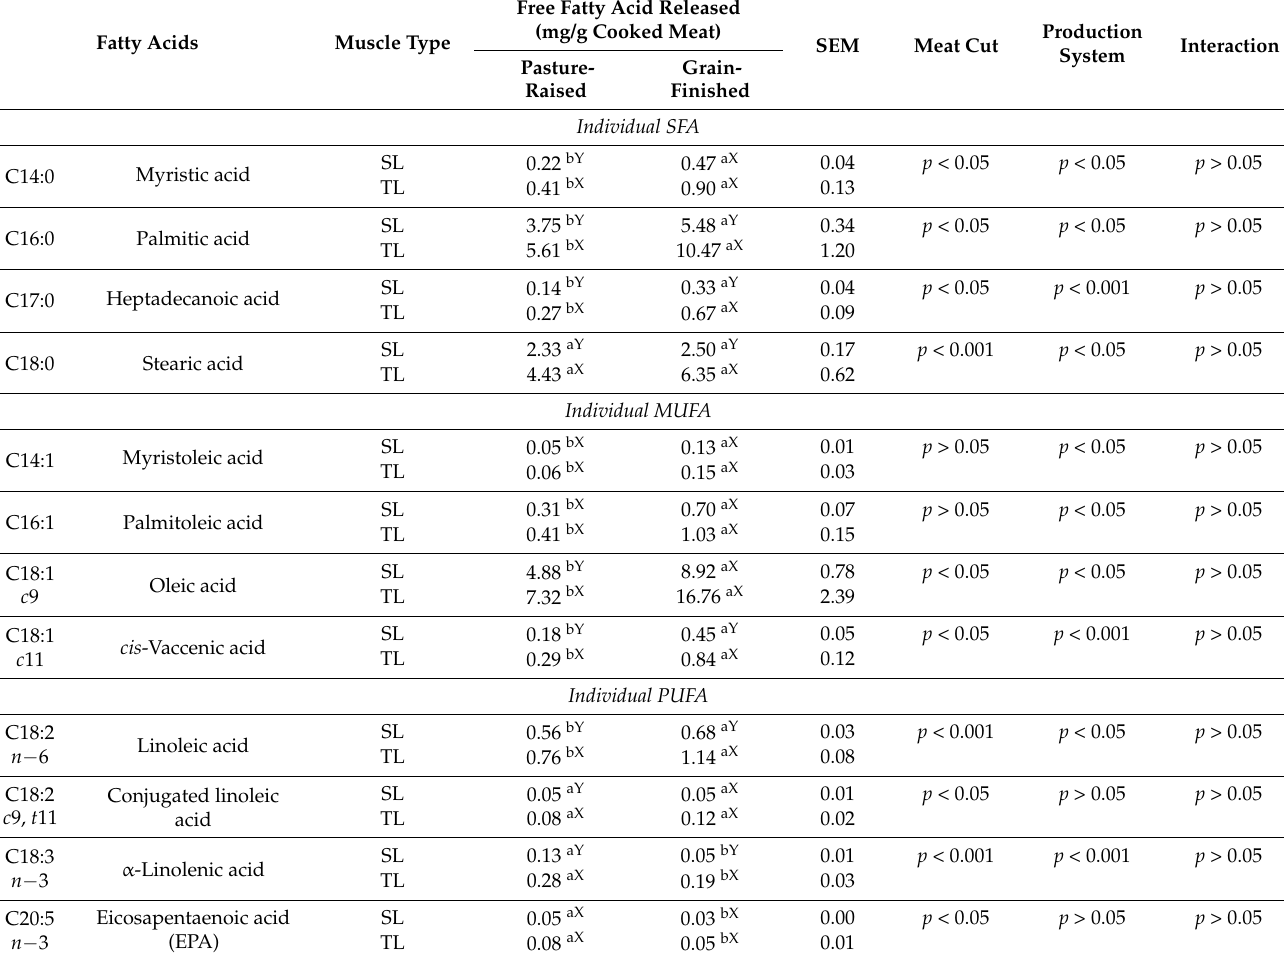
Table 4. Individual free fatty acids (selected) released after 180 min of simulated gastro-small intestinal digestion for cooked striploin (SL) and tenderloin (TL) from grain-finished and pasture- raised